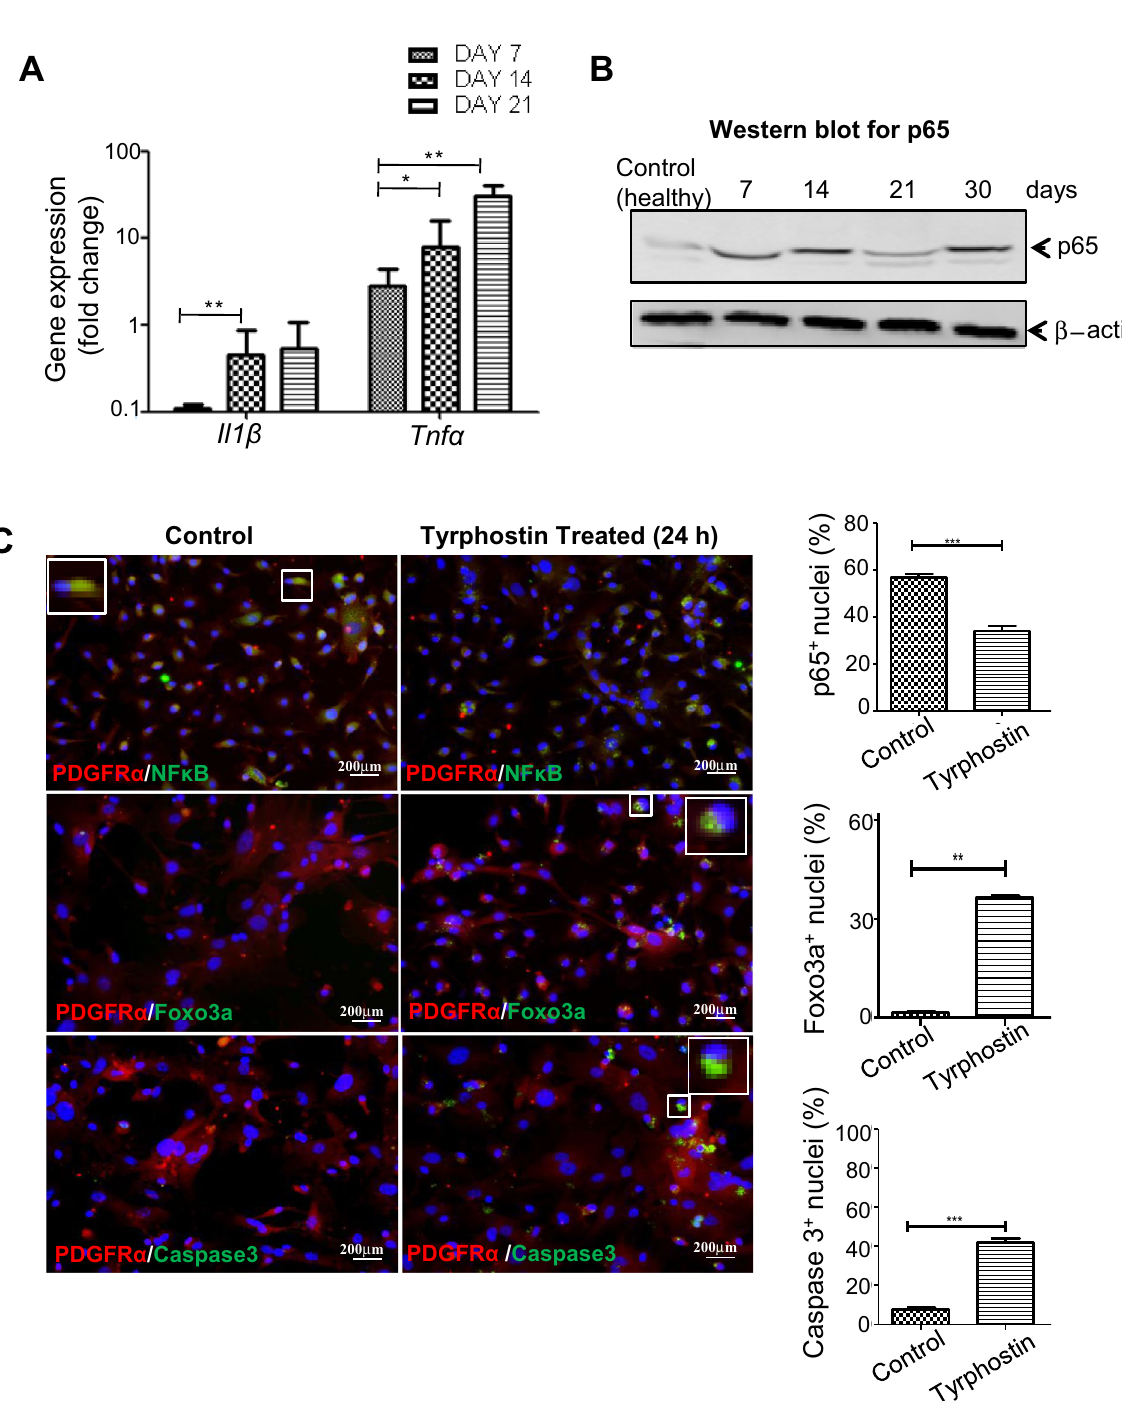
Figure 7. Local cues and activation of transcription factors. ( A ) Gene expression analysis. Quantitative gene expression analysis of the injured tissues shows relative mRNA of Il-1β and Tnfα expressions at days 7, 14 and 21 post muscle injury. ( B ) NF-κB activation in MFs of injured muscle. Nuclear translocation of p65 subunit at different times of the injury is shown. ( C ) Effect of Tyrphostin AG-370 on MFs in vitro. MFs are isolated from day 21 injured muscles and cultured for 24 h in the presence of plain medium (sham control) and Tyrphostin (20 μM). The resultant cells were analysed for the localization of p65NF-κB, Foxo3a and Caspase3 using specific antibodies. The bar diagrams show respective responses, determined on the basis of morphometric analyses of 6 fields each (20× magnification) using the ImageJ software. Data were presented as mean ± SEM. ***p < 0.001, **p <